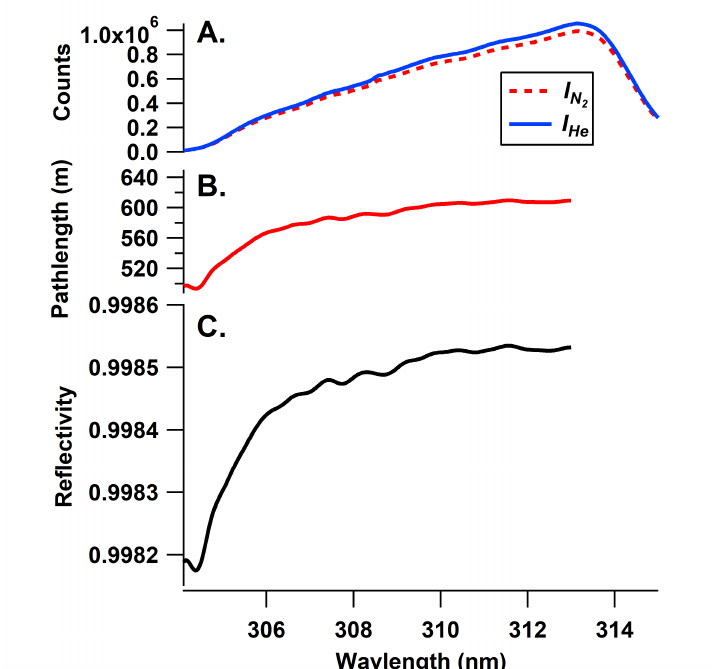
Figure 4. Panel ( A ): signal intensity in the presence of He and N 2 gas as used in Equation (1). Panel ( B ): effective pathlength (1/e) in meters. Panel ( C ): measured mirror reflectivity in the useable wavelength